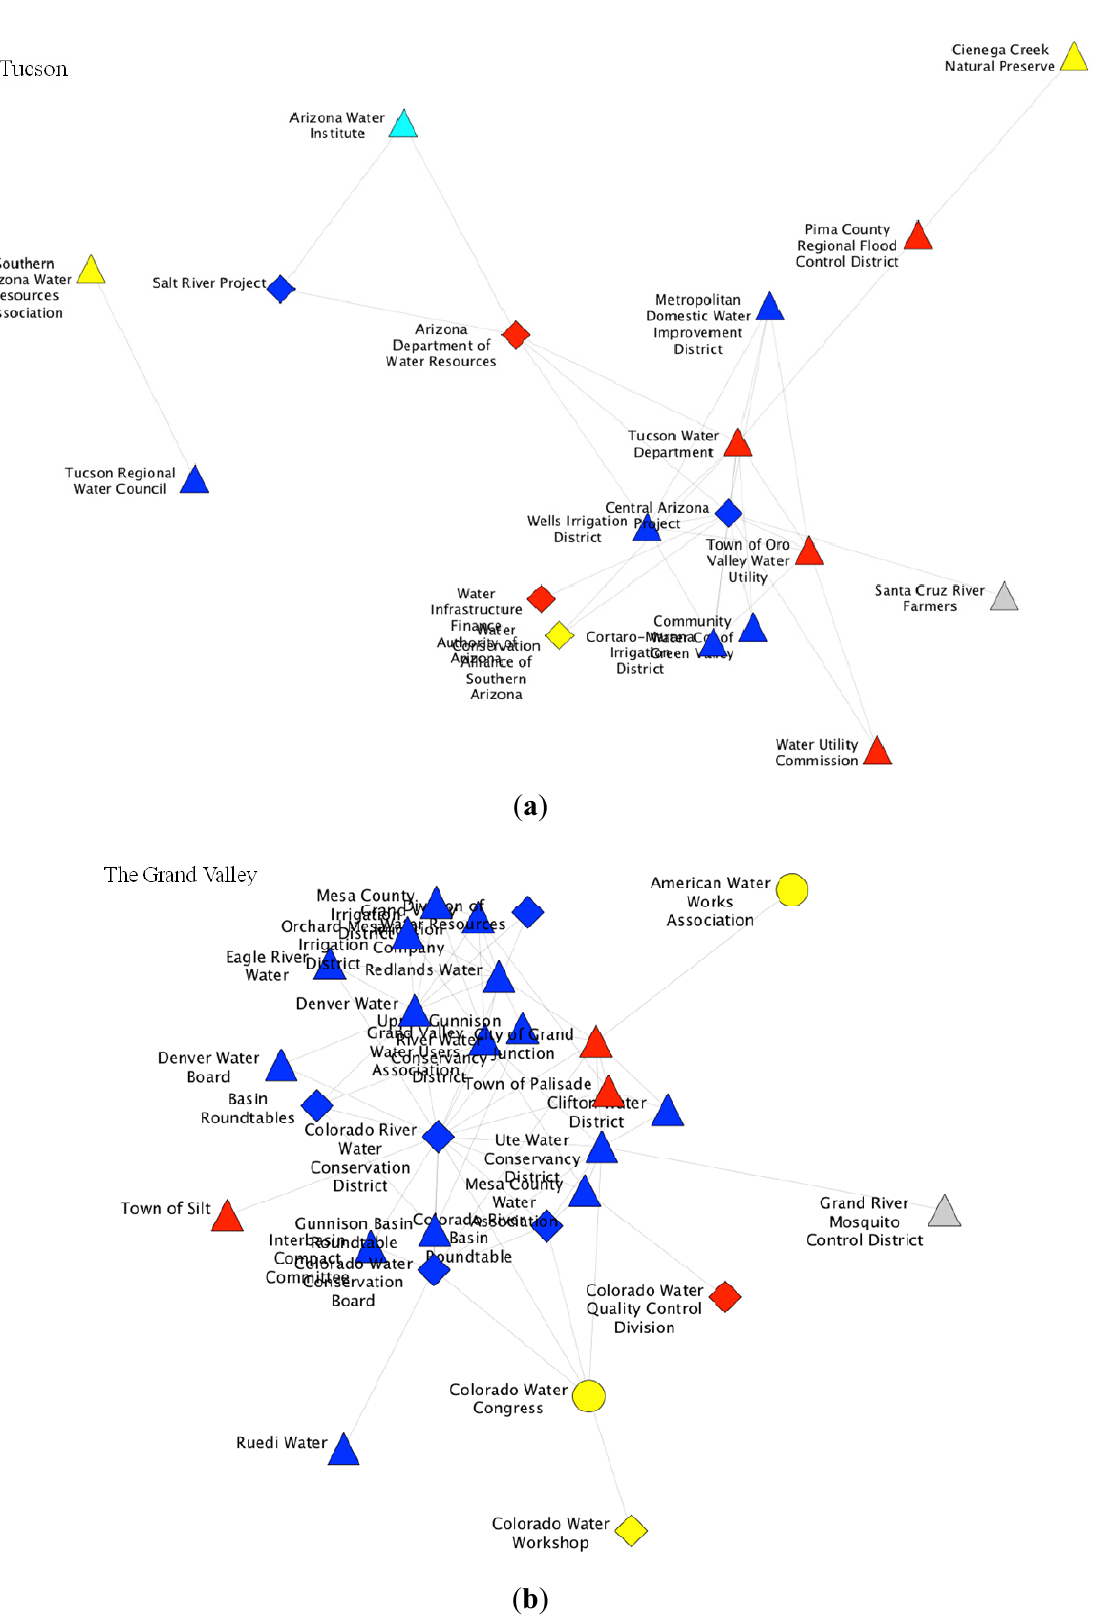
Figure 5. Networks generated from Step 3 results. ( a ) Tucson; ( b ) The Grand Valley; ( c ) Flagstaff; ( d ) Las